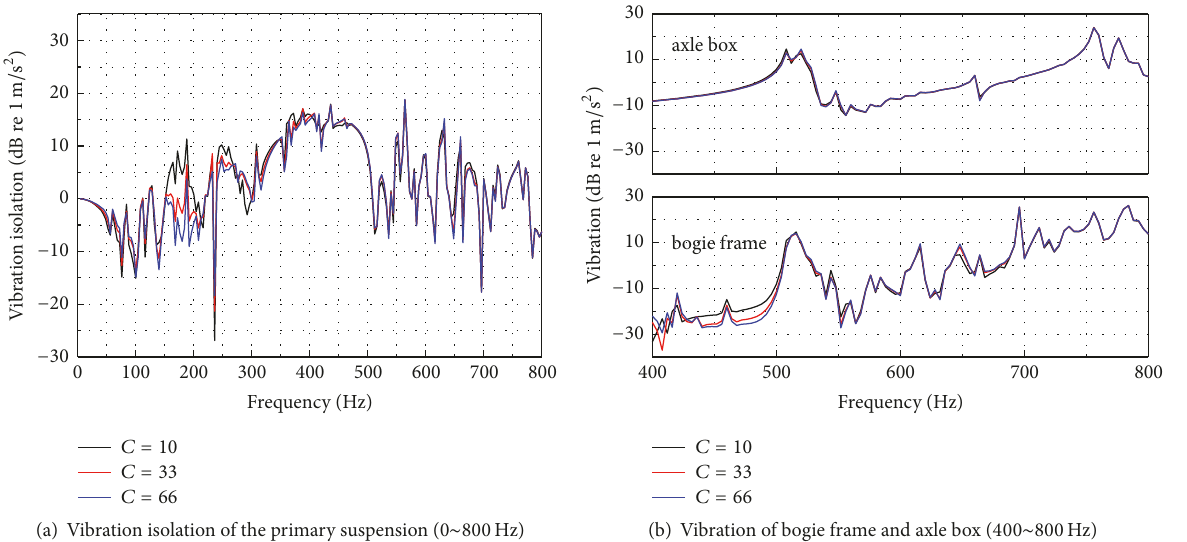
Figure 15: Different dampings of the vertical damper.